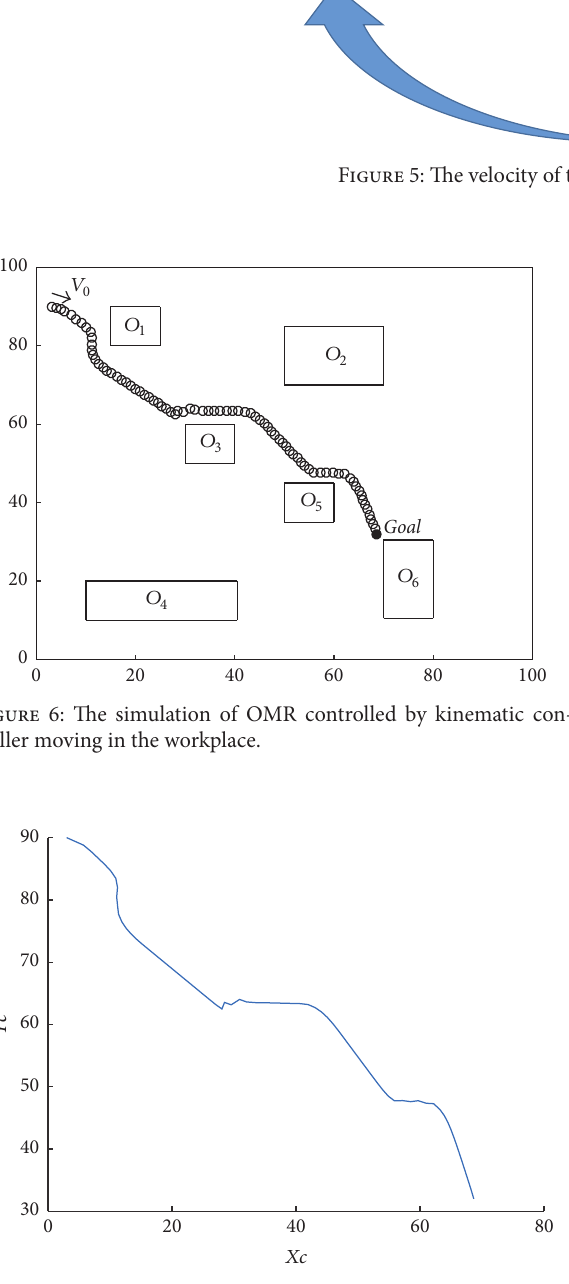
Figure 7: The trajectory of the OMR controlled by kinematic controller in 𝑋 𝑐 𝑂 𝑐 𝑌 𝑐 coordinate.